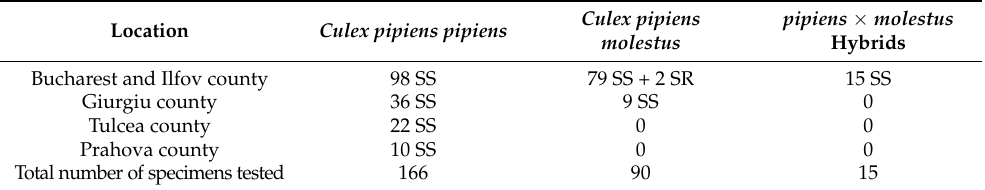
Table 2. Distributionofacetylcholinesterase1(AChE1)F290Vsubstitutioninthemosquitosamplesanalysed. Location Culex pipiens pipiens